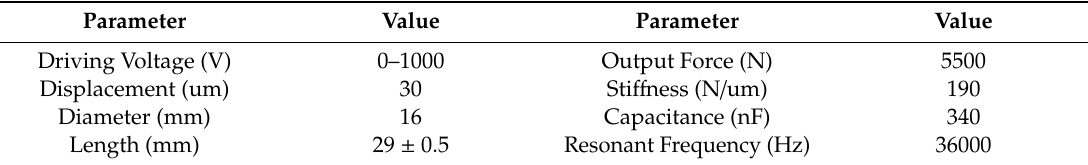
Figure 4. Diagram of multidimensional vibration suppression system.